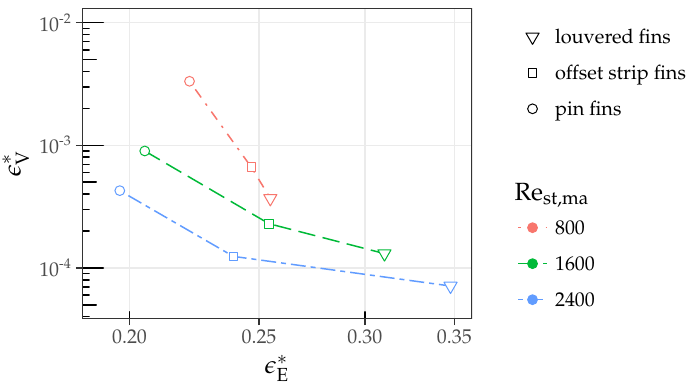
Figure 8. Pareto front of the bi-objective problem to optimize energy and volume efficiency. Fronts are given for three Reynolds numbers with three different enhancements in the feasible set Θ